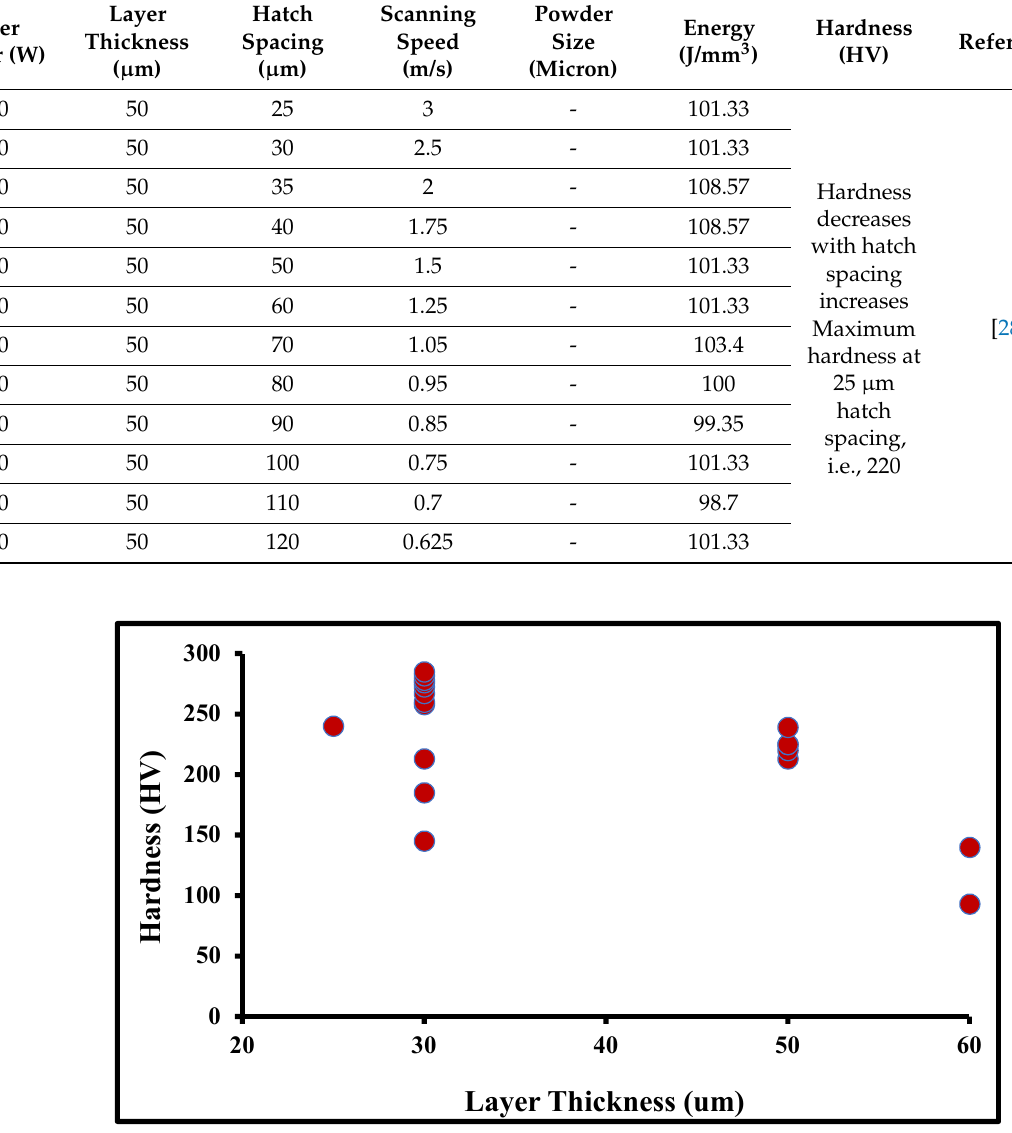
Figure 7. Hardness at different energy density. Tolosa et al. [29] also reported that as the energy density increases, the hardness in- creases up to 225 HV at 125 J/mm 3 . The hardness highly depends on the scanning speed, wherein the higher scanning speed leads to a faster cooling rate, which results in a finer